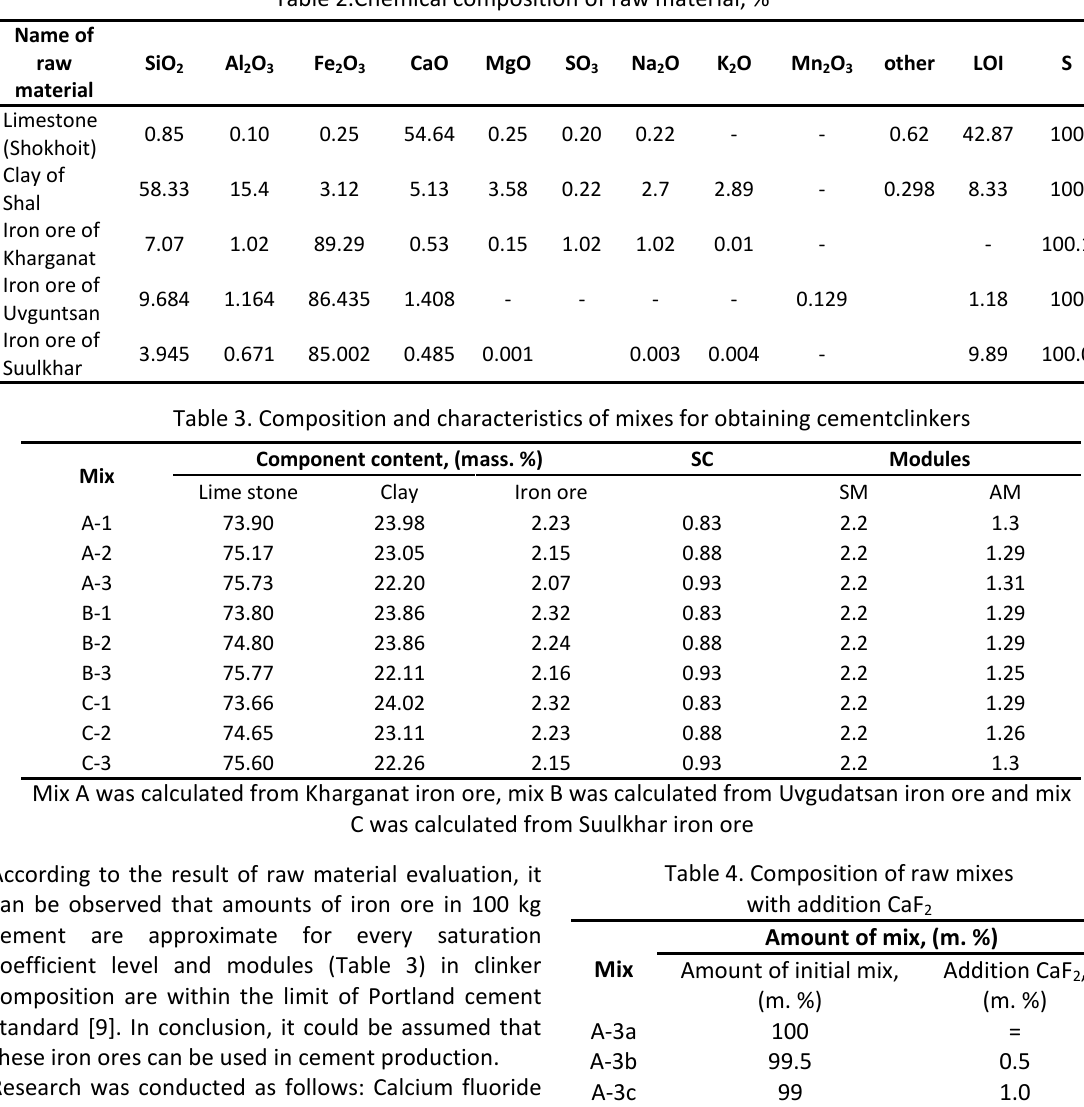
Table 2.Chemical composition of raw material, %